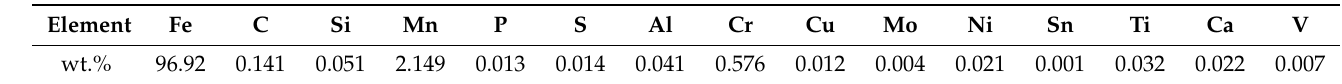
Table 1. Chemical composition (wt.%) of dual-phase